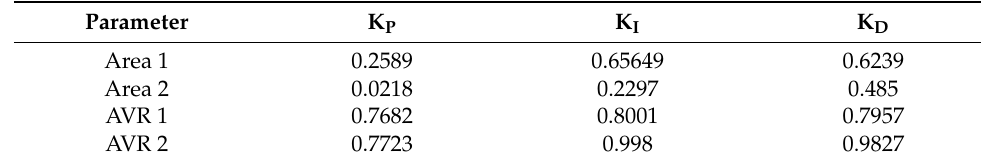
Table 15. PID parameters for the combined AGC and AVR system.